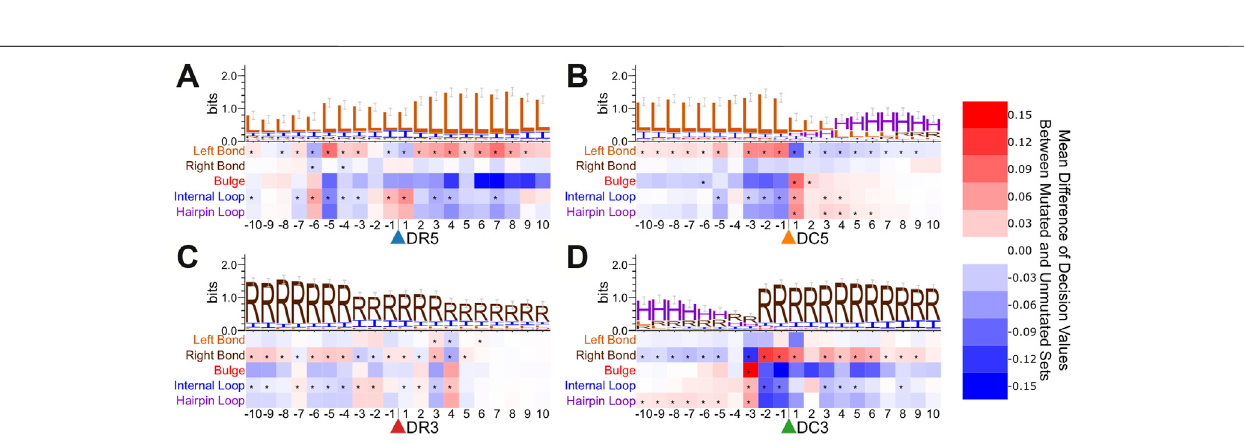
FIGURE 5 | Point mutation analysis for bpRNA sequence surrounding cut sites in the test set. Heatmaps show the average change in decision value due to point mutations within the enhanced bpRNA sequence surrounding cleavage sites of (A) . Drosha on the 5 ′ arm, (B) . Dicer on the 5 ′ arm, (C) . Drosha on the 3 ′ arm, and (D) . Dicer on the 3 ′